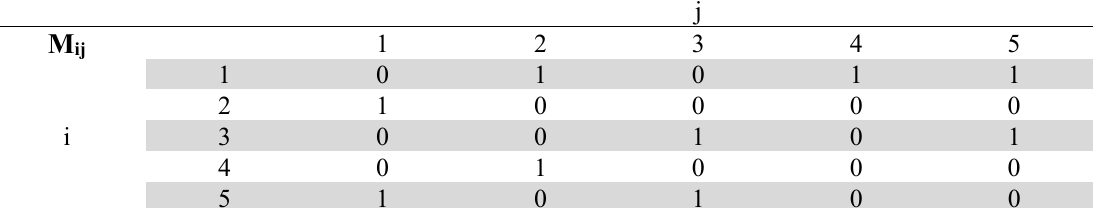
Interdependencies between projects